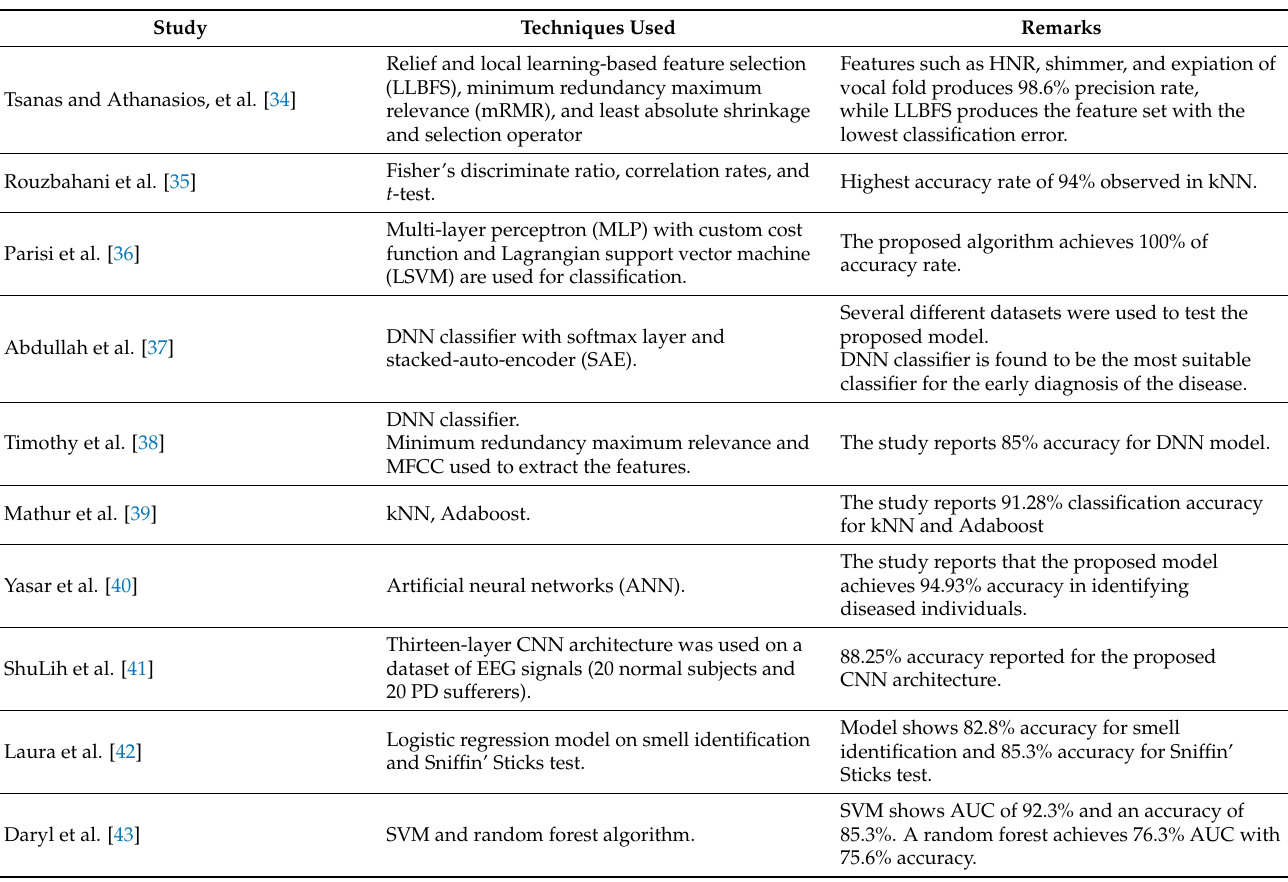
Table 1. Review of the